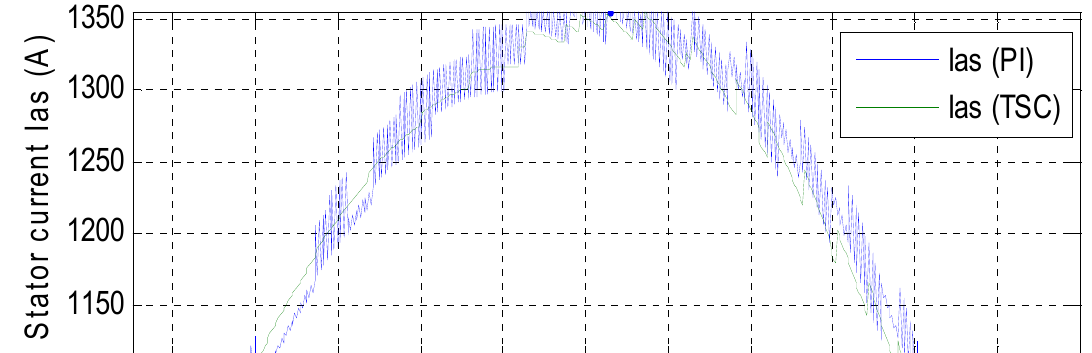
Figure 23. Zoom (Current).